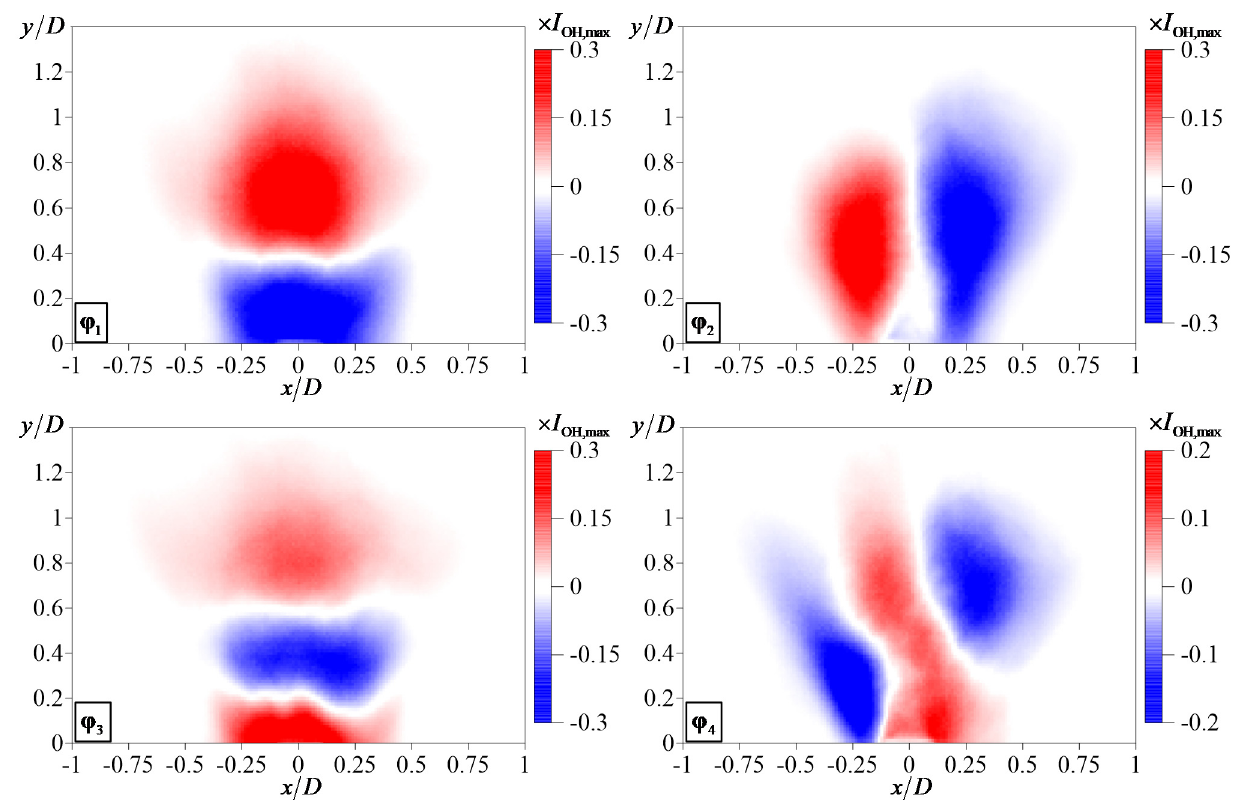
Figure 18. First four PCA modes of OH* chemiluminescence images for syngas flame at elevated conditions.